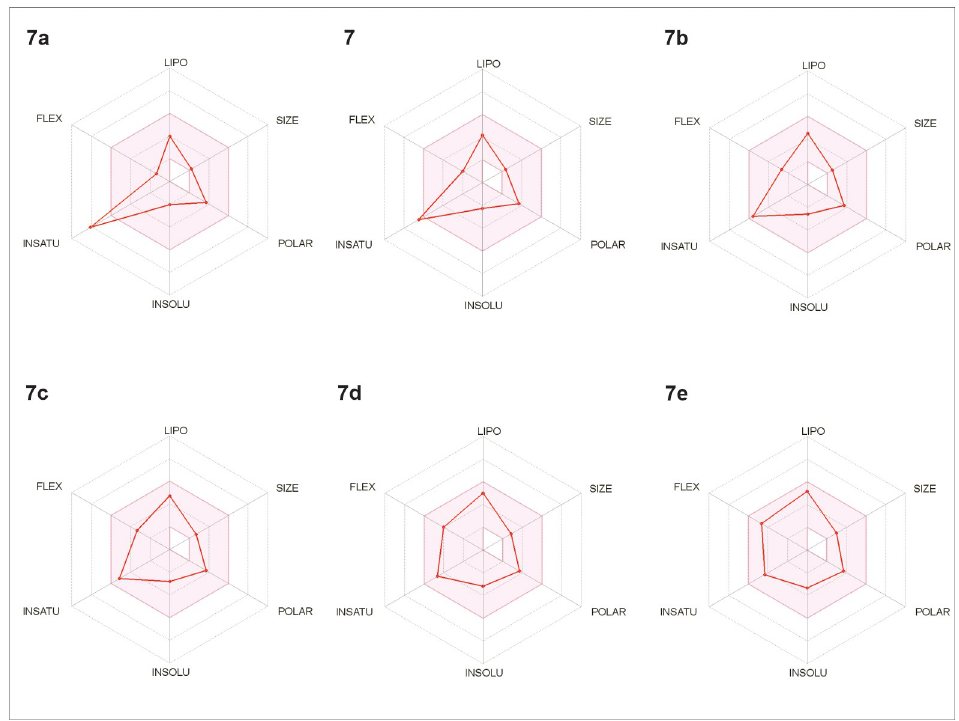
Fig 4. In silico study of drug-likeness for derivatives 7, 7a – 7e, using the SwissADME